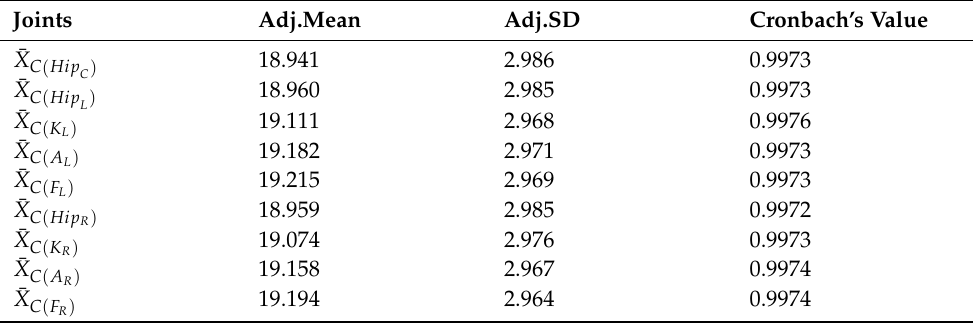
Table 4. The results of adjusted mean (Adj.mean), adjusted standard deviation (Adj.SD), and Cron- bach’s alpha for reliability of human body